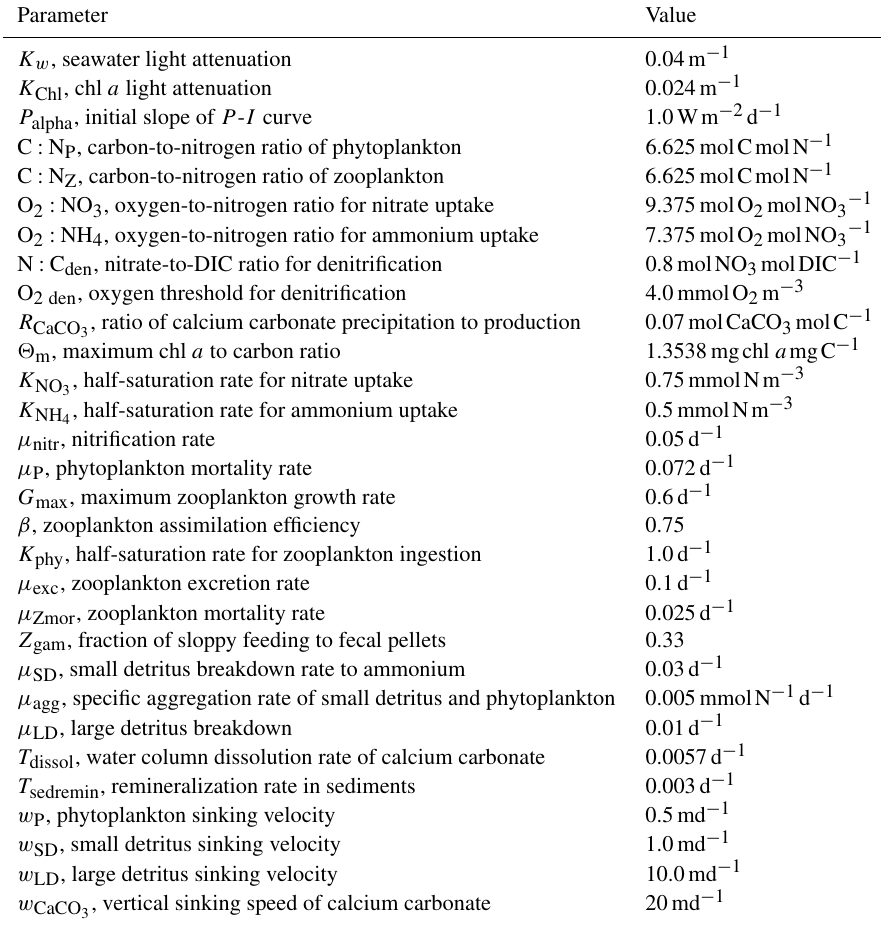
Table 2. List of parameters and their values used in the biogeochemical model. Parameter Value K w , seawater light attenuation 0.04m − 1 K Chl , chl a light